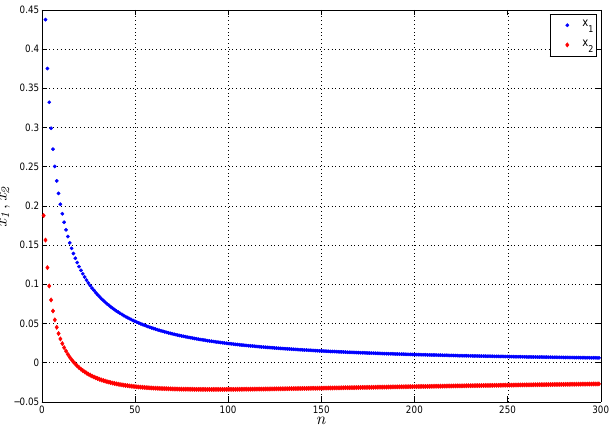
Figure 1. The stability of the zero solution of system